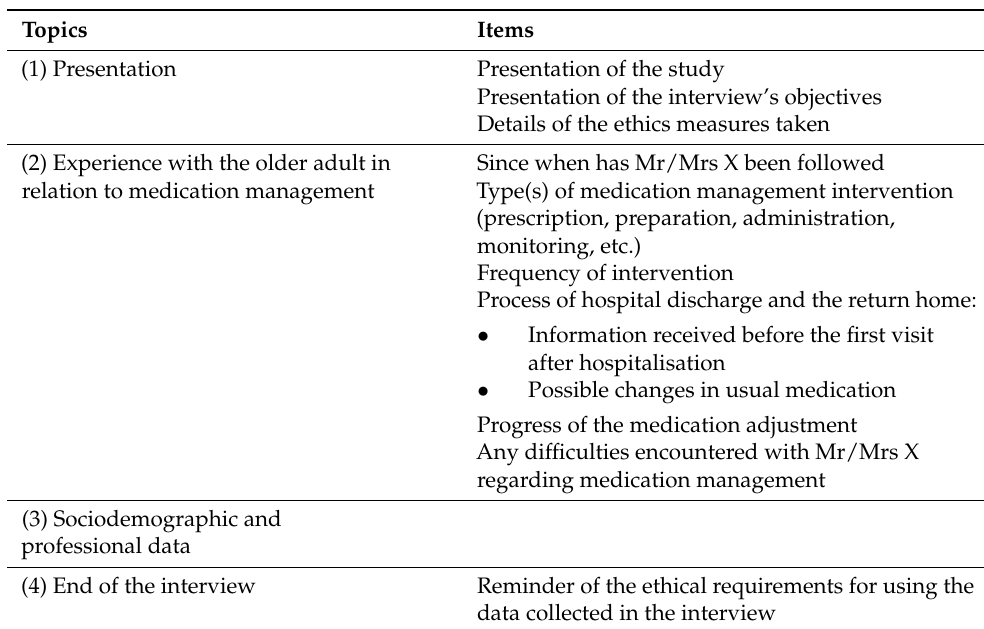
Table A4. Professional caregiver involved in medication